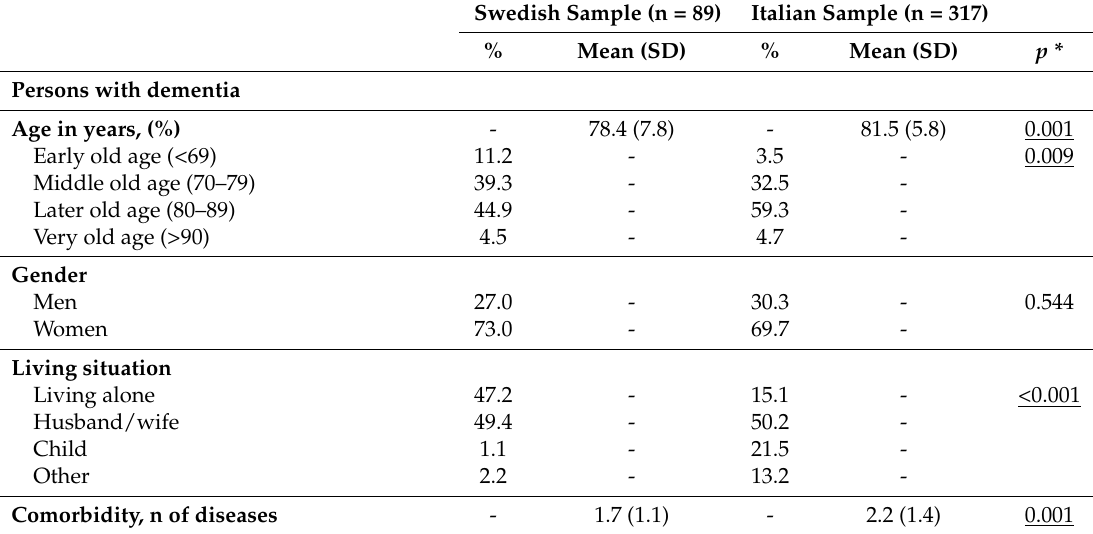
Table 1. Baseline characteristics of persons with dementia and informal